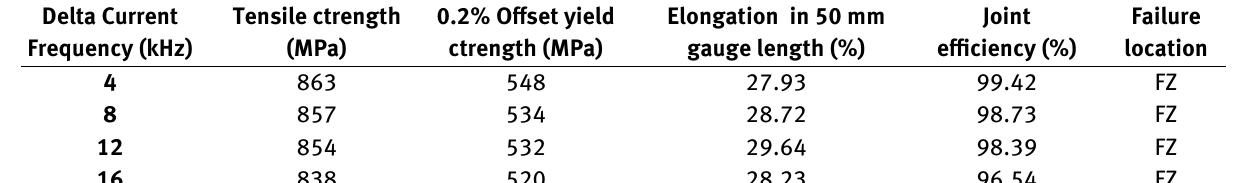
Table 7: Effect of DCF on transverse tensile properties of welded joints Delta Current